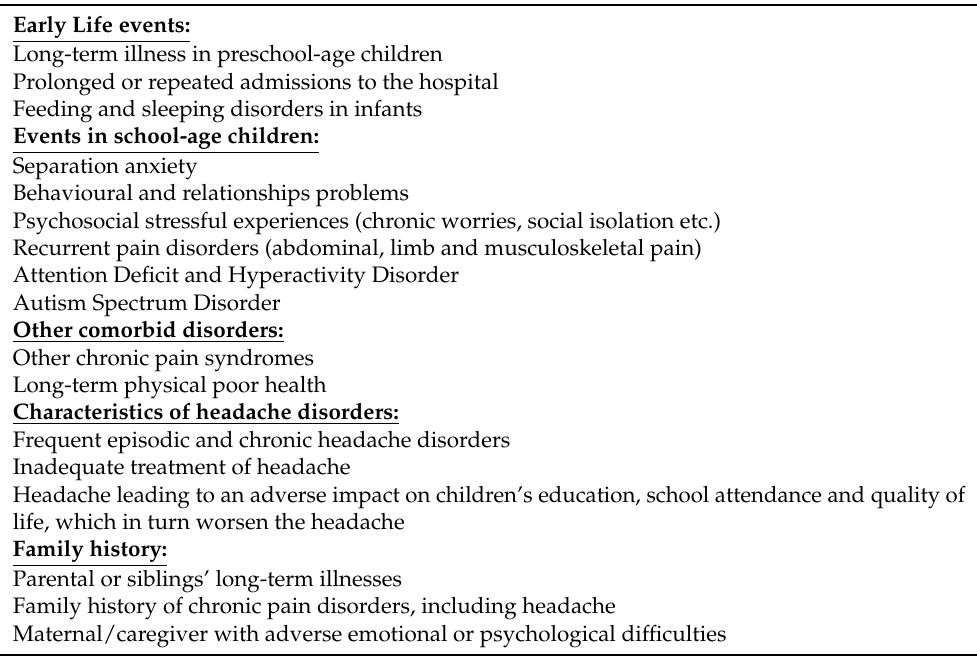
Table 1. Predictors of comorbid psychological disorders in children with primary headache